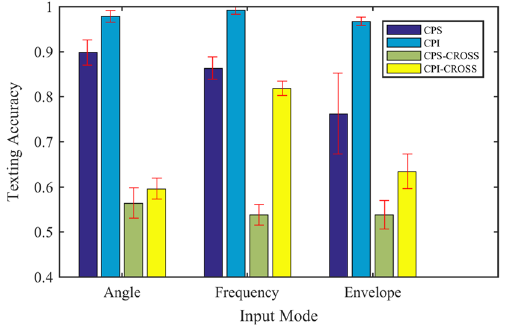
Figure 17. Influence of convolution weight setting on network performance.